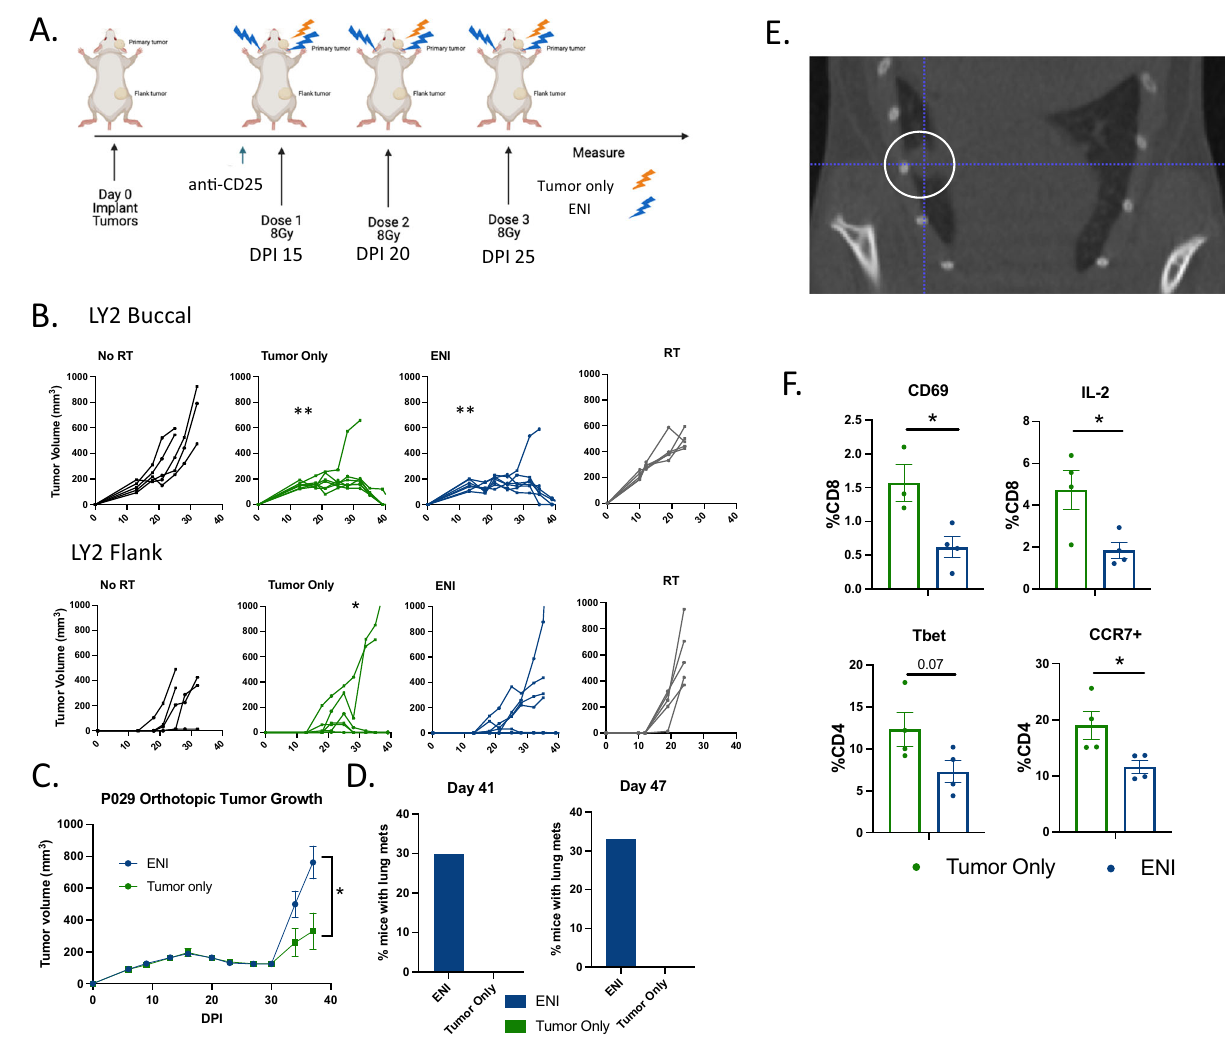
Fig. 1 | ENI ablates the immune response to combined radiation and immu- notherapy. A Schematic of the experimental design for gross tumor irradiation with or without elective nodal irradiation (ENI). Mice were implanted both in the buccal and in the fl ank on day 0 post-implantation (DPI). Stereotactic body irra- diation(SBRT)wasgivenwhentumorsreached~150mm 3 andanti-CD25wasgivena day before SBRT. Created with BioRender.com. B Tumor growth curves, from the experiment depicted in ( A ), Buccal tumor (top) and fl ank tumor growth curves (bottom) for mice treated with anti-CD25 ( n =5), anti-CD25 and tumor only SBRT ( n =7),anti-CD25andENI( n =7),andtumoronlySBRTalone( n =5). C Buccaltumor growth curves for mice implanted with the P029 cell line ( n =10 per group). Mice were implanted in the buccal on day 0 post-implantation (DPI). SBRT was given when tumors reached ~150mm 3 and anti-CD25 was given a day before SBRT and once a week thereafter. The doses of SBRT were spaced by 4 – 5 days. D Quanti fi cation of the percentage of mice with P029 tumors that had radio- graphicallydetectablelungmetastasesatdays41(ENI, n =10;tumoronly, n =7)and 47 (ENI, n =9; tumor only, n =7) post-tumor cell implantation. Lung metastases Mice implanted with B16-OVA melanoma cells were treated with ENI, bilateralneck irradiation, hadanincrease inprimarytumorand distant tumor growth (Supplementary Fig. 2B). Similarly, mice treated with ENI, bilateral axillary and inguinal node irradiation, implanted with the 4T1 cell line had a signi fi cant increase in distant fl ank tumor growth (Supplementary Fig. 2C) and increased lung metastasis. Metastasis in the lungs was visualized with microCT and quanti fi ed with H&E stain- ing (Supplementary Fig. 2D, E). We also repeated these experiments using anti-PD-1 as an immunotherapy in combination with radiation in